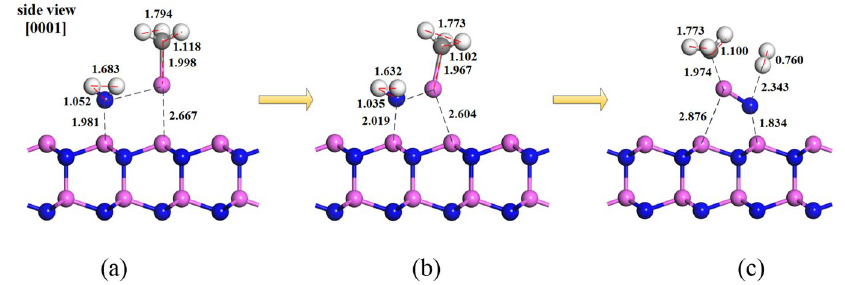
Figure 6. The desorption process of AlCH 3 and NH 2 molecules on the AlN (0001) surface; ( a ) Initial adsorption, ( b ) Stable adsorption and ( c ) Desorption state, where pink, blue and white spheres denote aluminum, nitrogen and hydrogen atoms, respectively. The digital signs show the distances, the unit is Å.